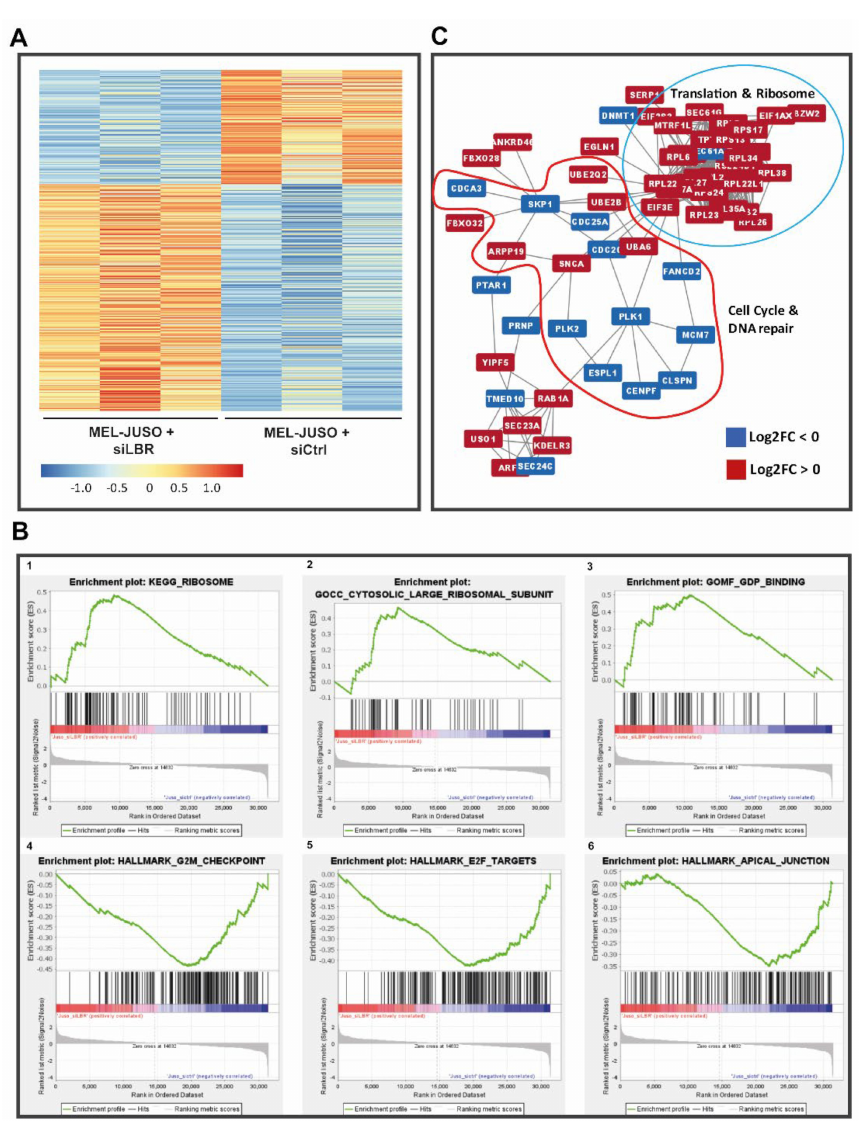
Figure 7. ( A ) Heatmap of differentially expressed (adj. p < 0.1) genes upon siLBR. ( B ) Enrichment plots (FDR < 25%) illustrating the profile of the running enrichment score (green) and positions